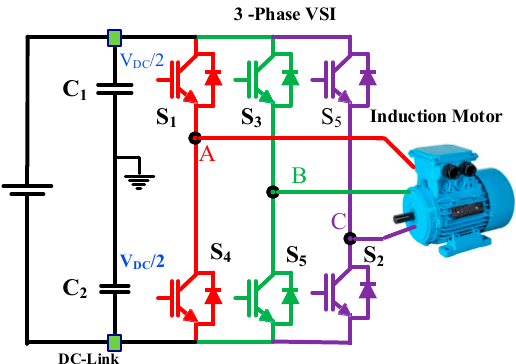
Figure 1. Three-phase VSI-fed inductor control. Figure 1. Three ‐ phase VSI ‐ fed inductor control. Figure 1. Three ‐ phase VSI ‐ fed inductor control.